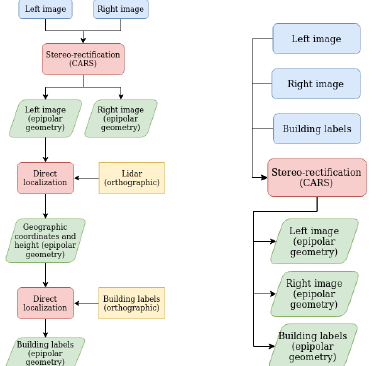
Figure 3. Pipelines used for the registration of building labels against satellite images : PHR image (left) and US3D dataset (right)